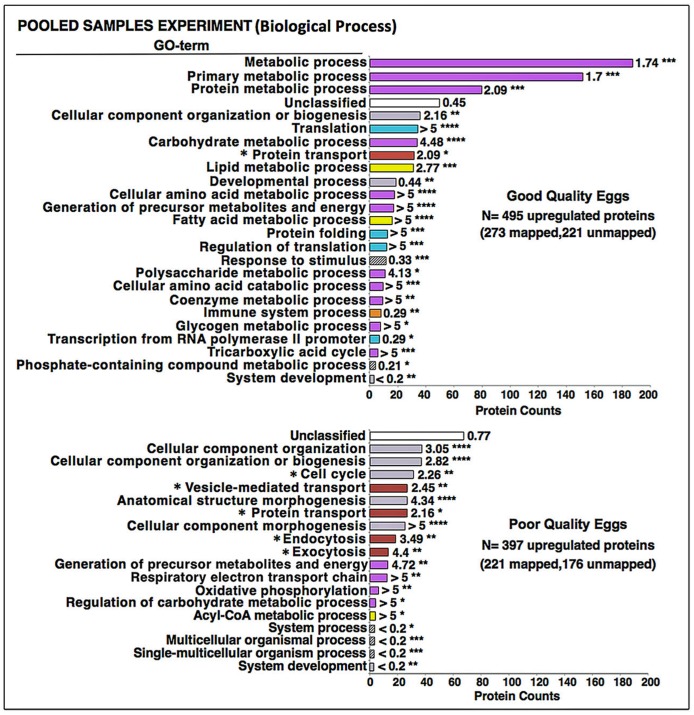
Enrichment of biological process gene ontology (GO) terms with proteins up-regulated in the Pooled Samples Experiment.Shown are the results of Protein ANalysis THrough Evolutionary Relationships (PANTHER) over-representation binomial tests [28] for enrichment of Biological Process GO terms with proteins up-regulated in good and poor quality zebrafish eggs in the Pooled Samples Experiment. Top Panel. Good quality eggs. Bottom Panel. Poor quality eggs. Horizontal bars indicate the number of proteins attributed to each GO term for which statistically significant results (p≤0.05 after Bonferroni correction for multiple tests) were observed. Numbers next to the bars indicate the fold-enrichment with proteins attributed to each term and the number of asterisks indicates the significance level of the enrichment, as follows p≤0.05 (*), p≤0.01 (**), p≤0.001 (***), and p≤0.0001 (****). Where possible, horizontal bars are colored to indicate corresponding protein functional categories shown in Fig 2; energy metabolism (magenta), cell cycle, division, growth and fate (lavender), protein synthesis (light blue), endosome/lysosome-related activities (brown), lipid metabolism (yellow), and immune system-related activities (orange). For poor quality eggs, GO terms preceded by an asterisk involve cytoskeletal activities. See text for details.